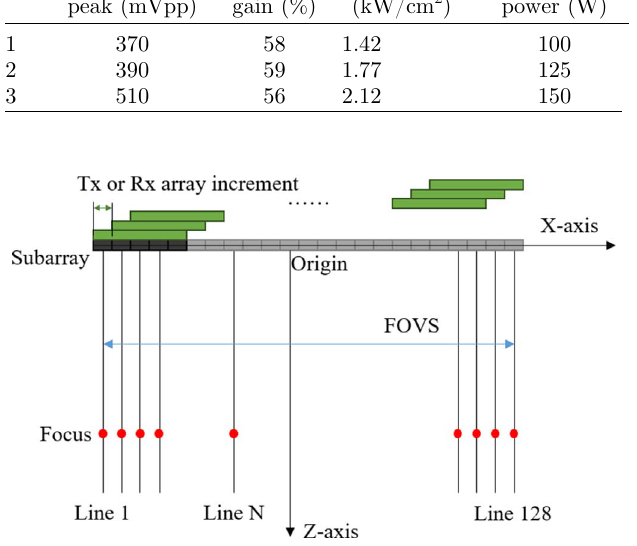
Figure 3. Principle of B-ultrasound imaging.